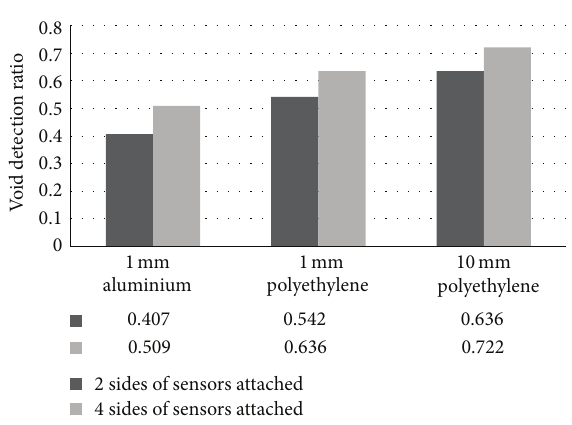
Figure 19: Void detection ratio for models with two-side and four- side sensor